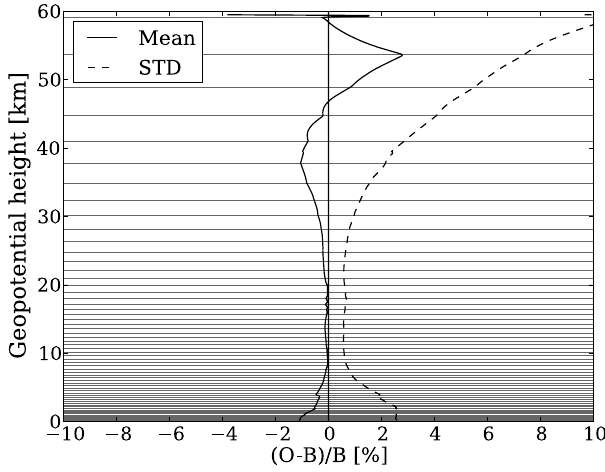
Figure 4. Refractivity innovations using the hydrostatic refractiv- ity expression between model levels (Eqs. 10 and 11) with typical heights of the model levels